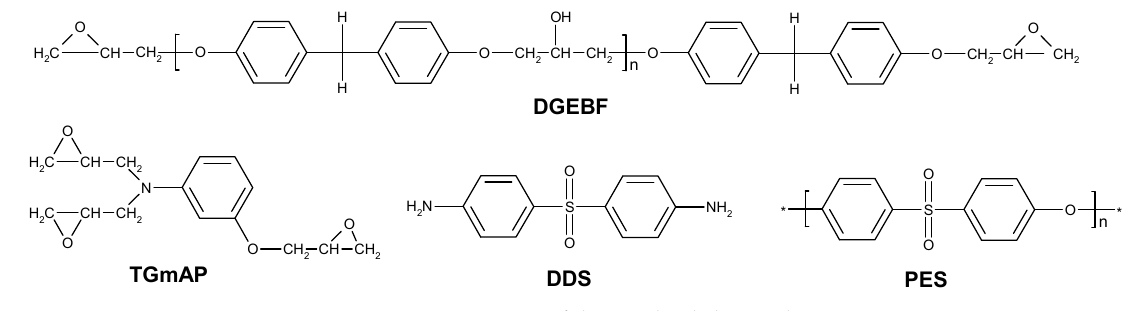
Figure 2. Structures of the involved